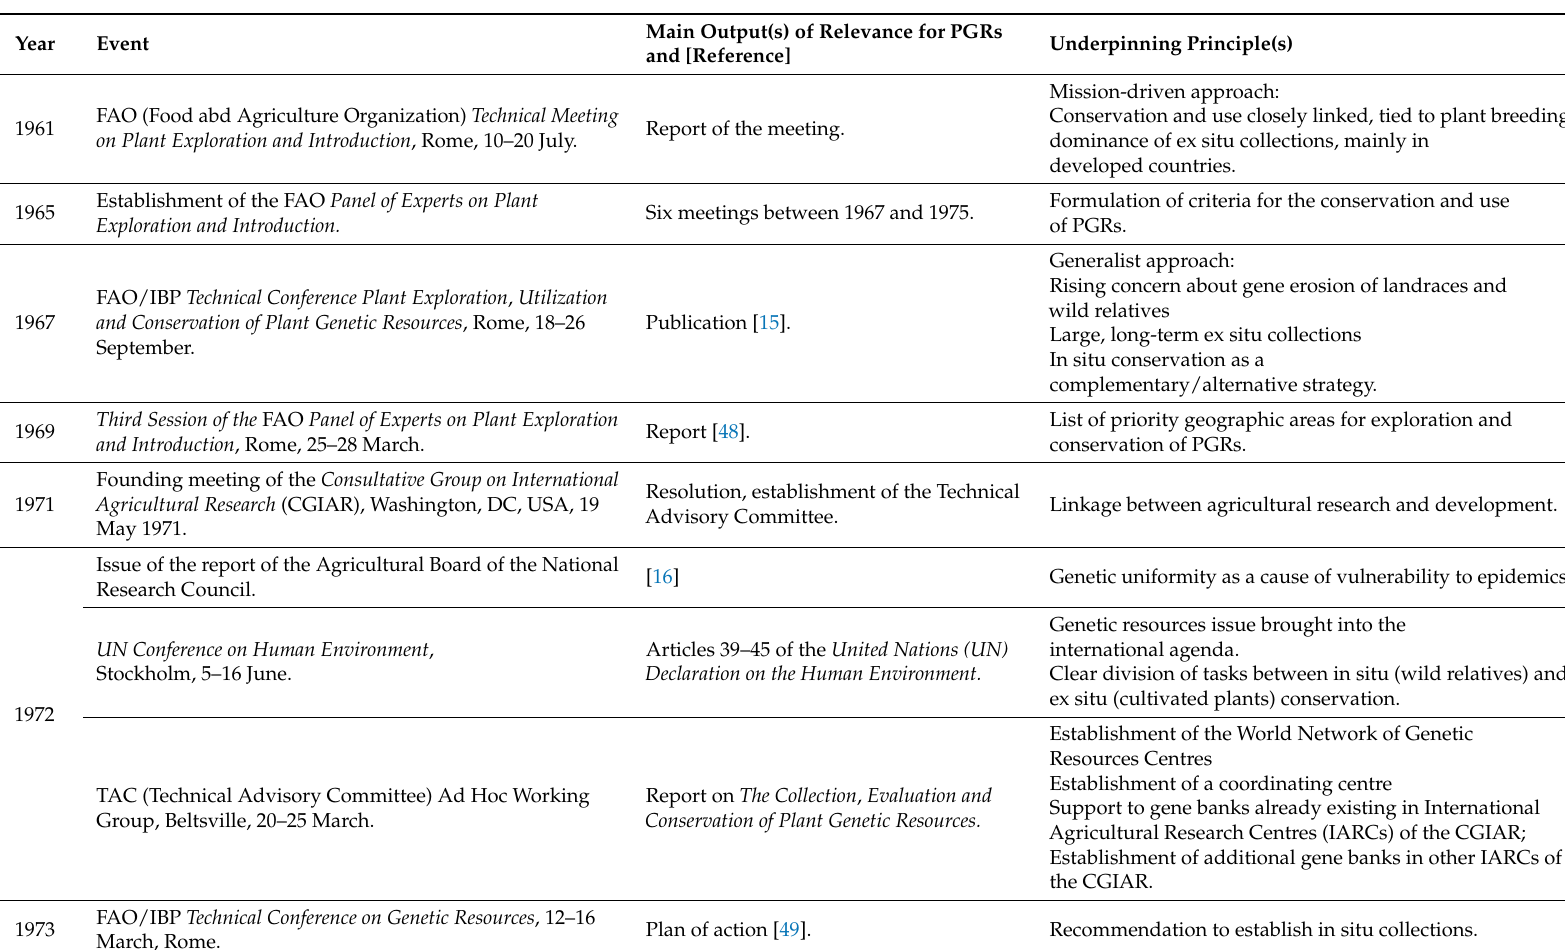
Table 1. Events relevant to the establishment and evolution of international instruments related to the conservation and sustainable utilization of Plant Genetic Resources